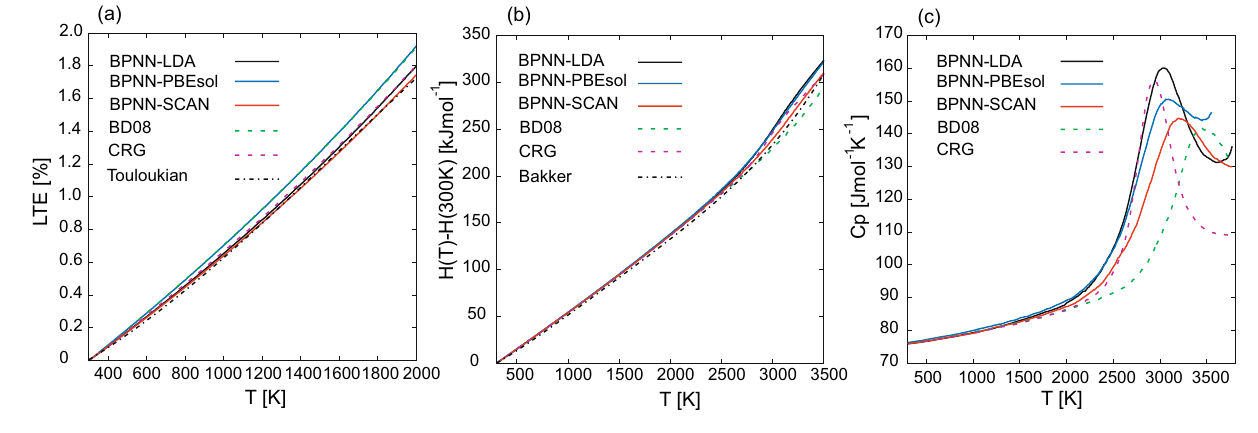
Figure 2. ( a–c ) Temperature dependence of the LTE, the enthalpy and the molar specific heat capacity. The solid lines are the results obtained by MLMD with BPNN-LDA (black line), BPNN-PBEsol (blue line), and BPNN-SCAN (red line), respectively, whereas the dashed lines are the results computed by MD with BD08 (green line) and CRG potential (purple line). The black dashed-dot line in ( a,b ) represent the Touloukian 62 and the Bekker fitting 64 equations for the experiment.